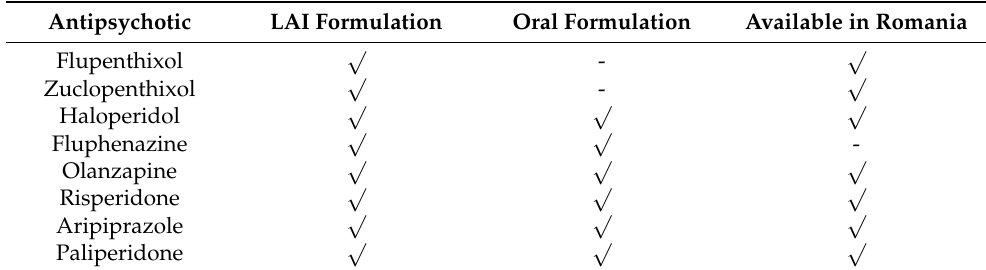
Table 1. Antipsychotics with LAI formulations.